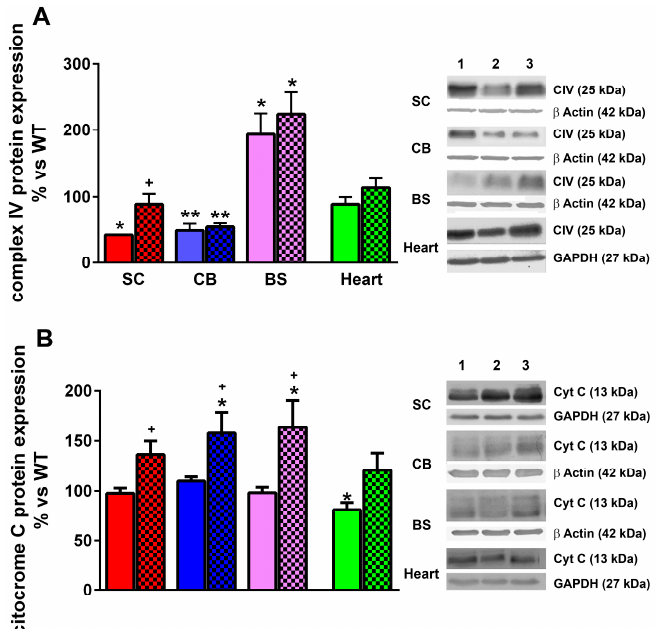
Figure 7. LGF treatment modulates Complex IV and cytochrome C expression in YG8R mice. ( A ) The effect of LGF on Complex IV (CIV) expression, analyzed by western blot in the spinal cord (SC, red bars), cerebellum (CB, blue bars), brain stem (BS, lilac bars), and heart ( green bars) of WT, YG8R ( uniform bars), and YG8R+LGF (bars with mesh ) mice. Note that the level of this compound is significantly reduced in the spinal cord and cerebellum in YG8R mice versus WT mice, and LGF only reverses CIV reduction in the spinal cord; In ( B ) the effect of LGF on cytochrome C is observed in the same structures. Note how cytochrome C expression is reduced in the heart of YG8R mice, and how LGF treatment increases its levels in all the structures analyzed. Lane 1 (WT), Lane 2 (YG8R), Lane 3 (YG8R+LGF). Results are the mean ± SEM of three (in the case of spinal cords) or 6–8 (in the rest of structures) independent animals. * p < 0.05, ** p < 0.01 vs. WT; + p < 0.05 vs. YG8R. Glutathione is the most abundant non-enzymatic antioxidant in cells [27] and its oxidized form is increased in FA [25,28]. In the skeletal muscle of YG8R mice, the ratio of oxidized glutathione (GSSH) to reduced glutathione (GSH) was upregulated. LGF treatment reduced this parameter to the values observed in WT mice (Figure 8). This effect was due to the increase in GSH promoted by the factor in this structure (313 ± 54, 263 ± 46, +449 ± 69 ng/g of tissue in WT, YG8R and YG8R+LGF mice, respectively. + p < 0.05 vs. YG8R, n = 6 independent mice in each experimental group).